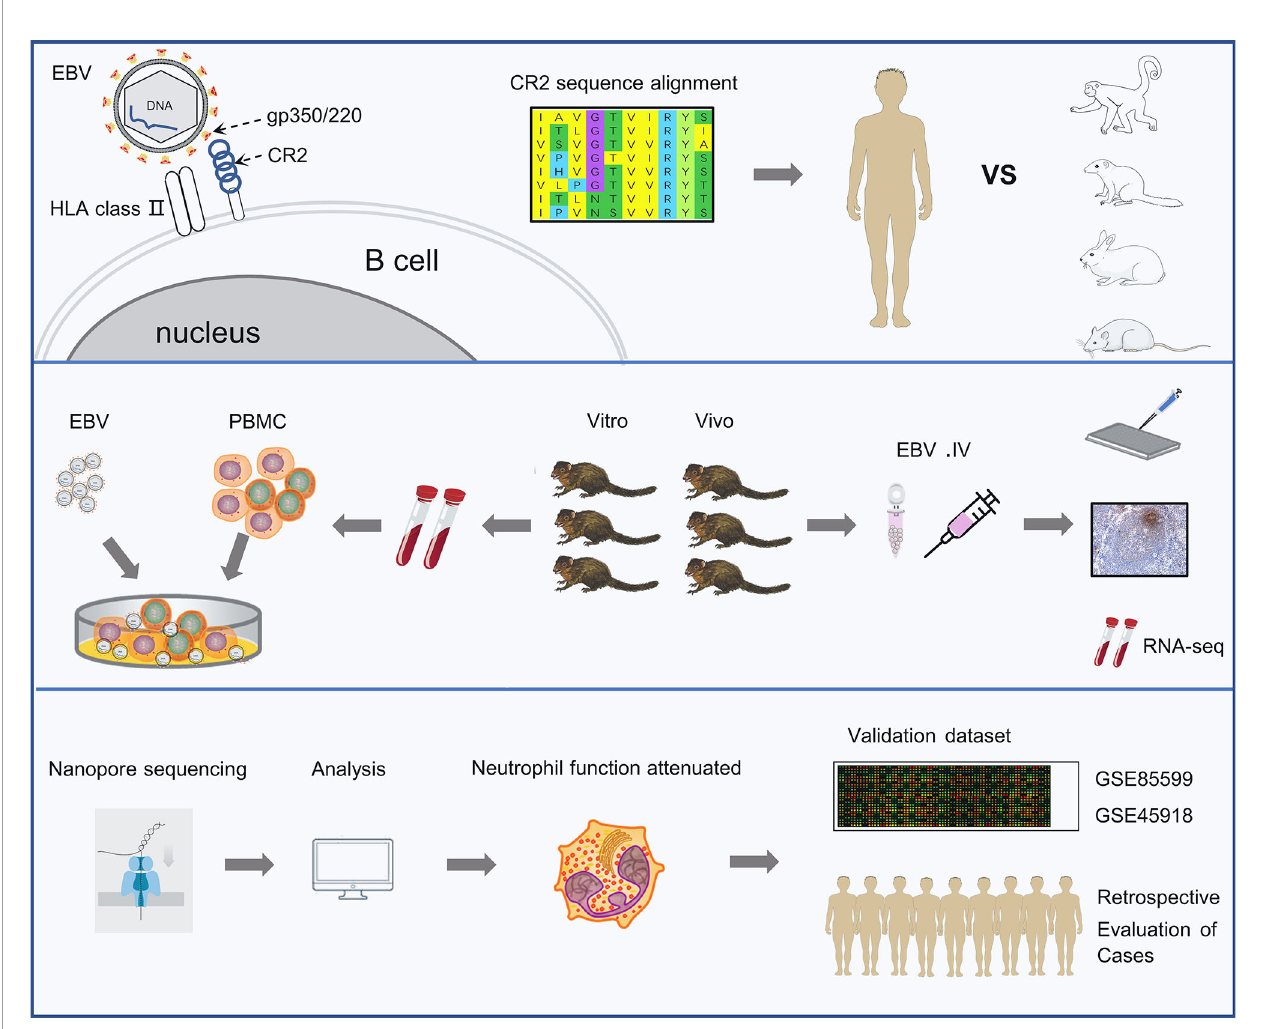
FIGURE 1 | Schematic representation of the study. The experiments were completed in 3 phases. The fi rst is identifying the key residues in the CR2 receptor that bind the gp350 protein and facilitate viral entry. The second is analyzing the characters of EBV infection in tree shrews both in vitro and vivo . The last phase was revealing the dynamic changes in biological processes occurring during EBV primary infection by RNA sequencing and validating fi ndings using two external validation set and retrospective case